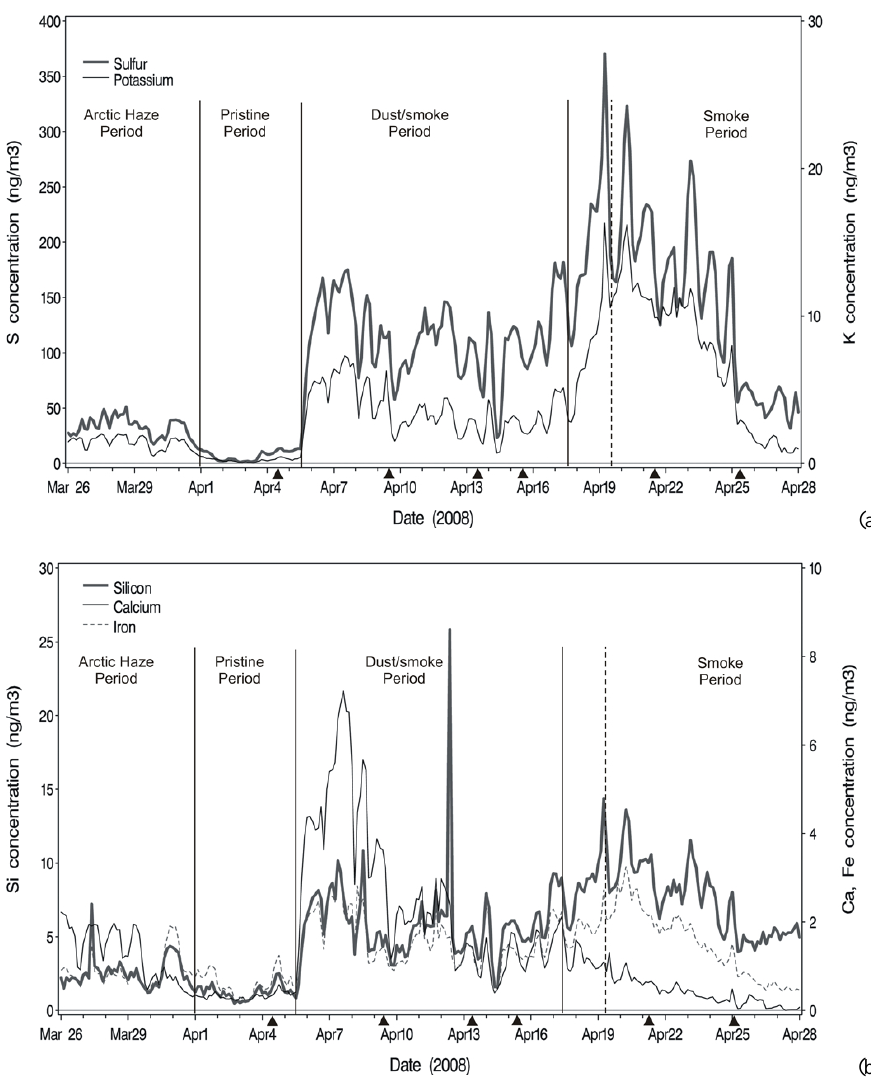
Fig. 3. DRUM Impactor sampler species traces: (a) wildfire species (S, Ca); (b) mineral (Si, K) and industrial species (Fe). Sampled size fraction: 0.1 to 0.34µm. Times of CPL data gathering periods (black triangles) and the day of the OPC balloon-sonde (vertical dashed line) are indicated. The aerosol periods identified in the Discussion are also separated by the thin vertical lines. Minimum detectable limits are as follows (ngm − 3 ) : S: 3.1, Ca: 0.3, Fe: 0.4, Si: 2.6, K: